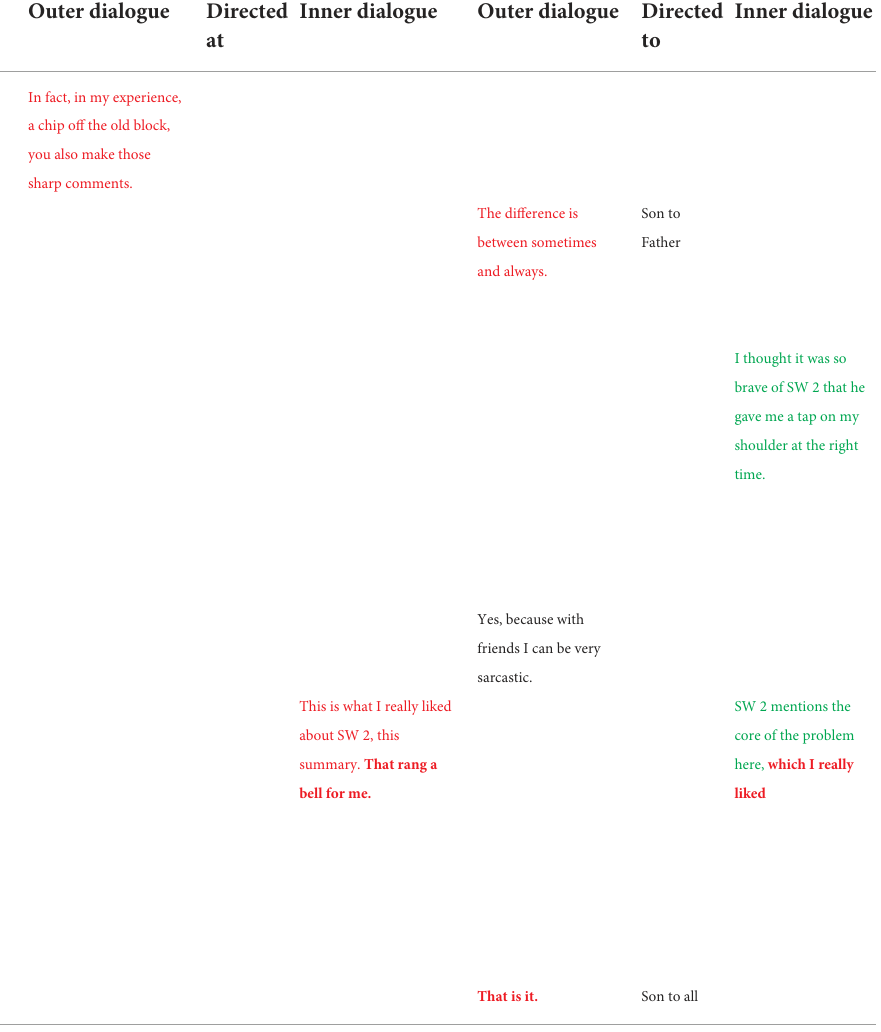
Red,past;Green,present;Blue,future. Italics,innerdialogueduringprimaireconversation.